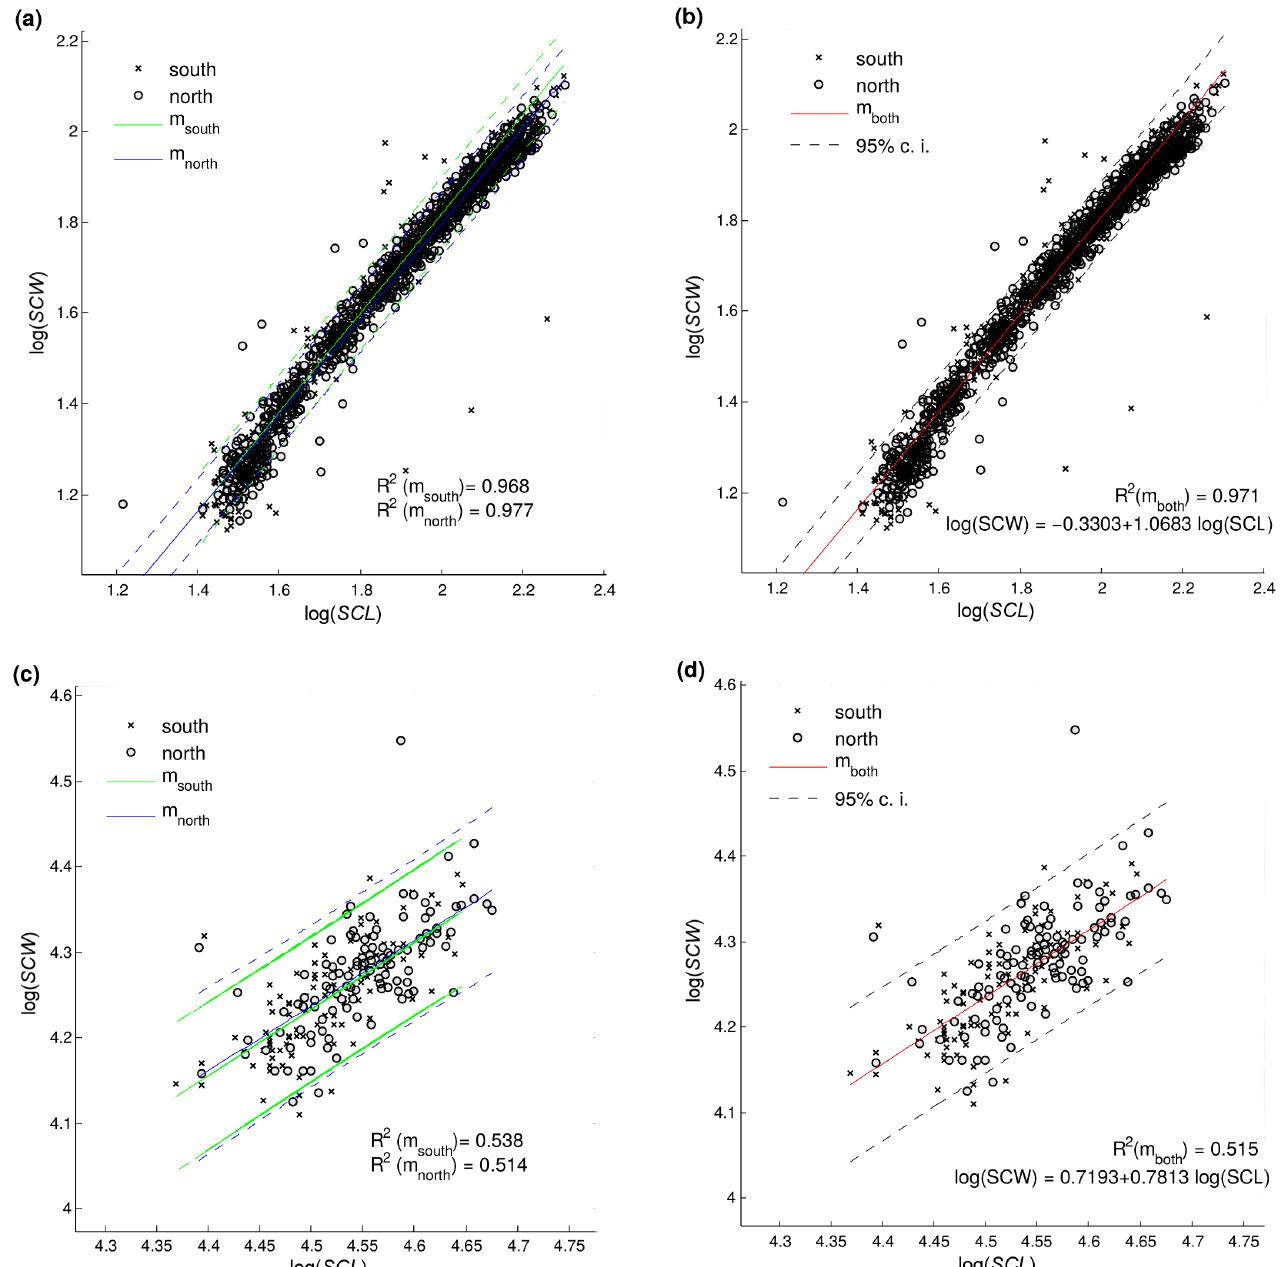
Fig 1. Predictions of log( SCW ) from log( SCL ) by regression equations ‘ m north ’ , ‘ m south ’ , and ‘ m both ’ specific for regional subsets ‘ north ’ , ‘ south ’ , and ‘ both ’ . Panels (a) and (b): data from the posthacthling group. Panels (c) and (d): data for the adult group. The recommended regression equations are displayed in the plot, while the parameters for remaining equations are provided in Table 3. Dashed lines mark the 95% confidence intervals of the predictions.